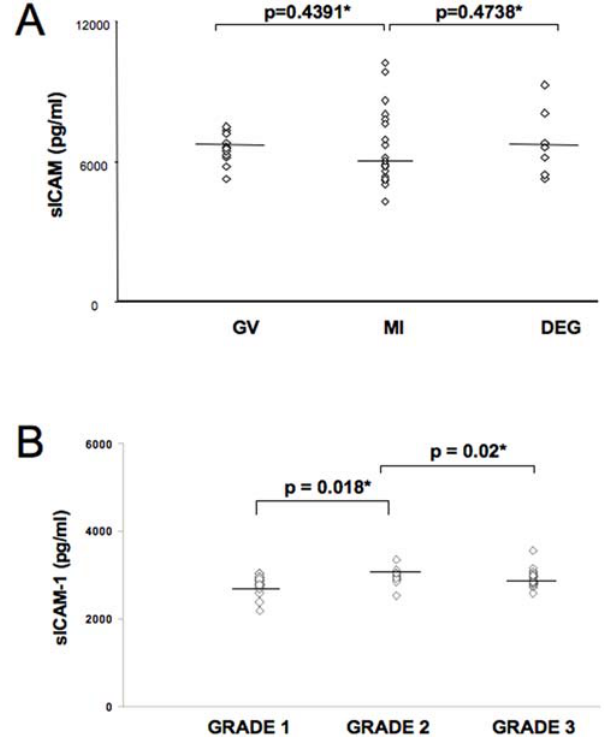
Figure 3. Western blotting analysis. The anti-ICAM-1 MoAb was used for the detection. a: standard positive control loaded at 8000 pg; b: plasma sample loaded at 10000 pg, accordingly to ELISA detection; c: medium negative control; d: mature oocyte supernatant loaded at 35 pg accordingly to ELISA detection; e: immature oocyte supernatant loaded at 100 pg accordingly to ELISA detection; M: protein